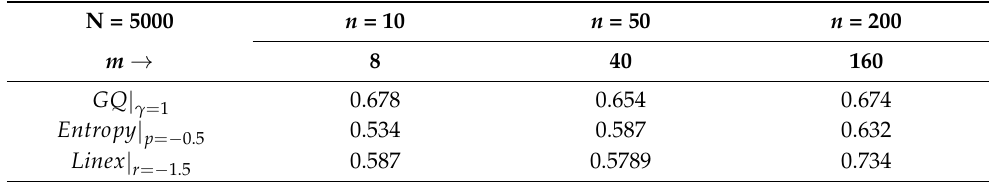
Table 11. Pitman comparison of the